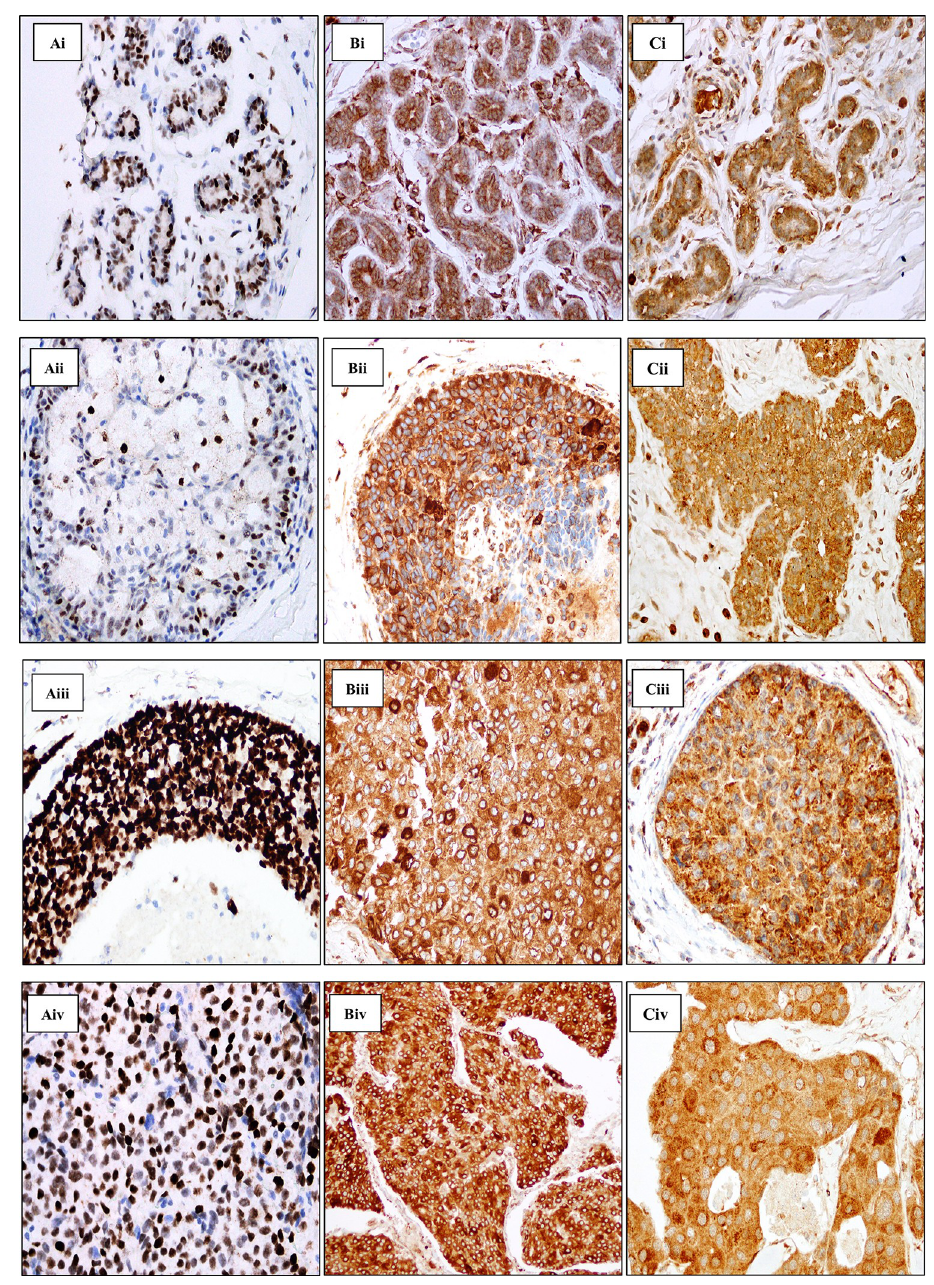
Fig 1. Immunohistochemical staining of P53 (A), DCR2 (B) and DEC1(C). Ai-Aiv shows clear and distinct nuclear staining of P53 in the respective tissues. Bi-Biv shows DCR2 immunoreactivity in the cytoplasm with minor protein expression masking over the nucleus in the respective tissues. Ci-Civ shows DEC1 moderate and strong granular staining of the cytoplasm in the respective tissues. i: Normal tissue, ii: Atypical Ductal Hyperplasia (ADH), iii: Ductal Carcinoma in situ (DCIS), iv: Invasive ductal carcinoma (IDC). Magnification